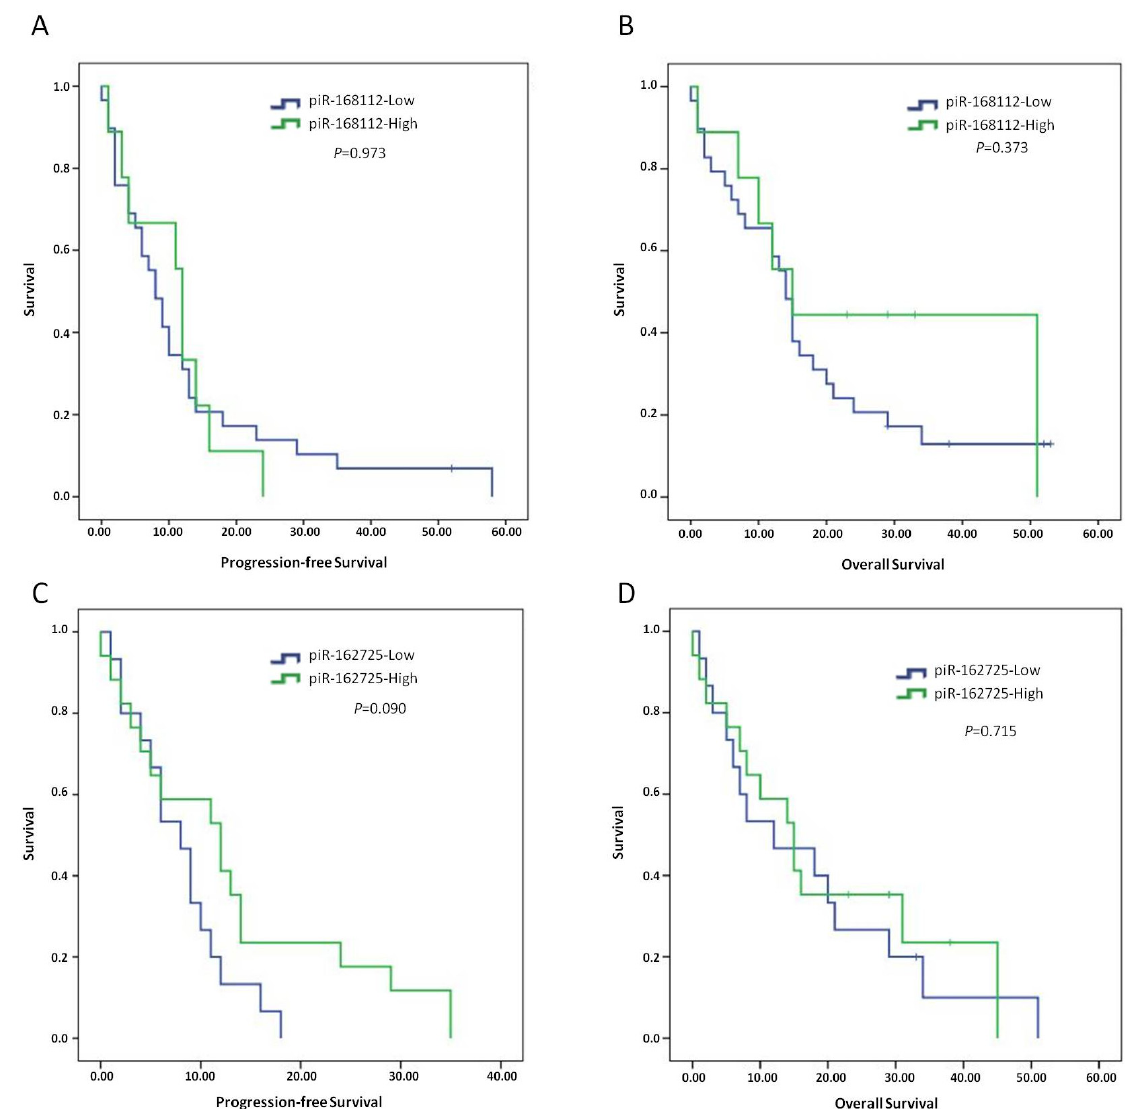
Figure 5. Survival curves according to the expression levels of both tumourigenic piRNAs. ( A ) Kaplan–Meier curve for progression-free survival according to piR-168112 expression. ( B ) Kaplan–Meier curve for overall survival according to piR-168112 expression. ( C ) Kaplan–Meier curve for progression-free survival according to piR-162725 expression. ( D ) Kaplan–Meier curve for overall survival according to piR-162725 expression. Statistical analyses were performed using the log-rank test. p -values < 0.05 were considered statistically significant.